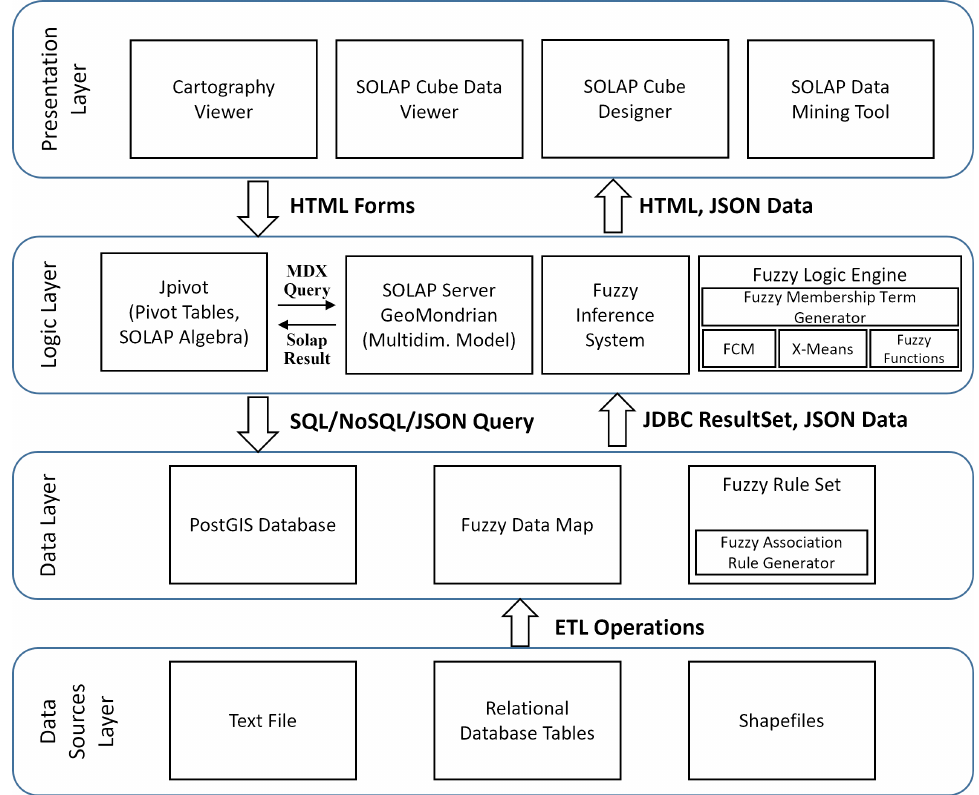
Figure 2. Multilayer framework architecture of